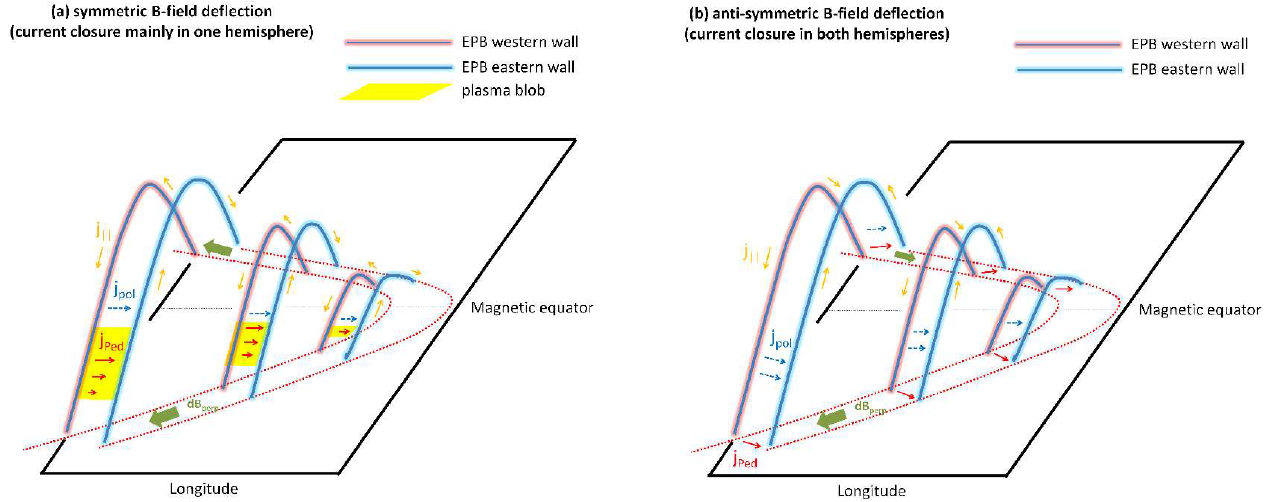
Fig. 3. A schematic diagram of FAC circuits associated with (a) EPBs and blobs (b) EPBs only (adapted version of Fig. 8 in Park et al. (2009)). Yellow patches mark locations of plasma blobs.